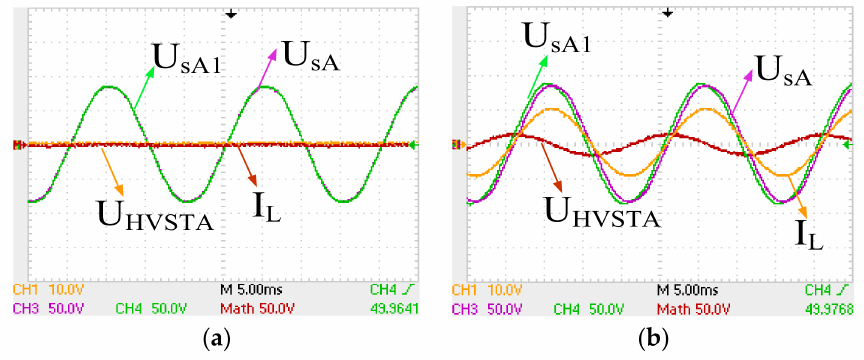
Figure 16. Experimental waveforms of the HVST operating at different tap positions. ( a ) Tap position at (0, 0); ( b ) Tap position at ( − 2,